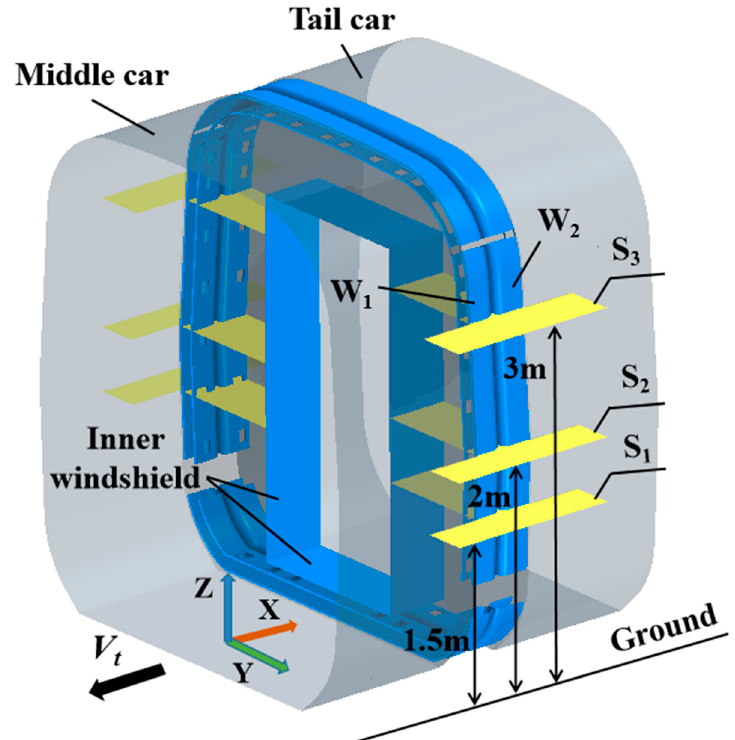
Figure 7. The position distribution of the horizontal section.